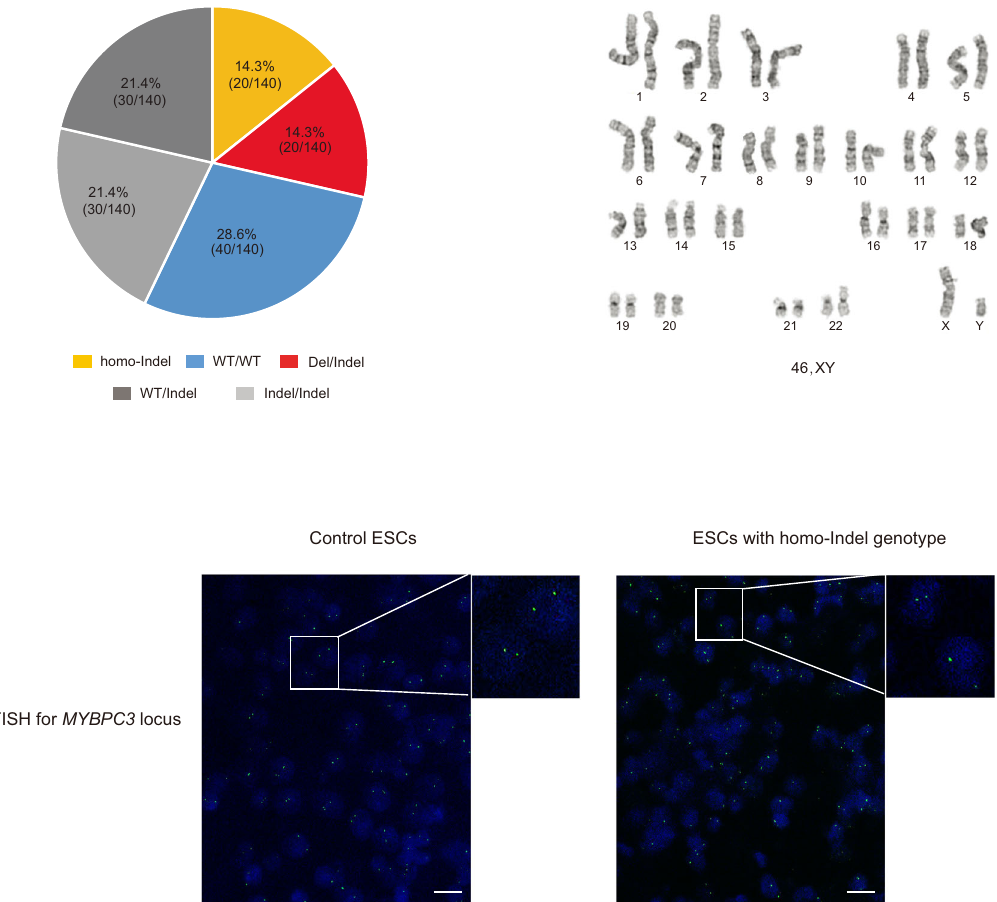
Fig.3|BiallelicDSBrepairat MYBPC3 locusinhumanESCsderivedfromedited embryos. a MYBPC3 genotypes in 14 ESC lines derived from CRISPR/Cas9 injected embryos. In contrast to embryos, a fewer ESC lines carried homo-indel genotypes. b G-banding analysis con fi rming that all ESC lines with MYBPC3 homo-Indel genotype exhibit normal diploid karyotypes without any detectable large deletions. c FISH